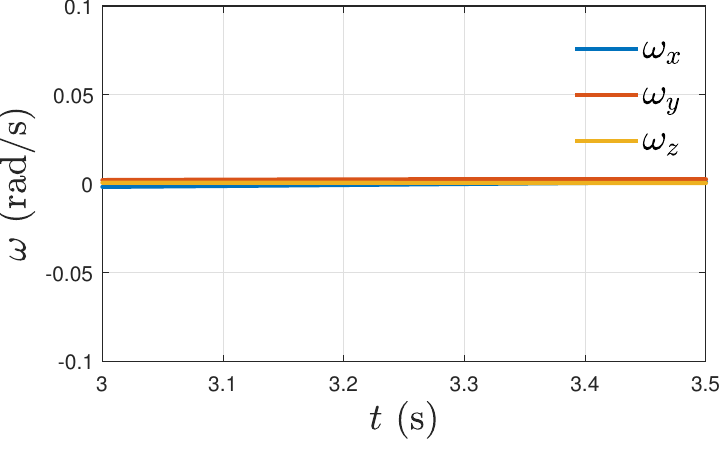
Figure 16. Zoomed-in plot of components of ω for D =